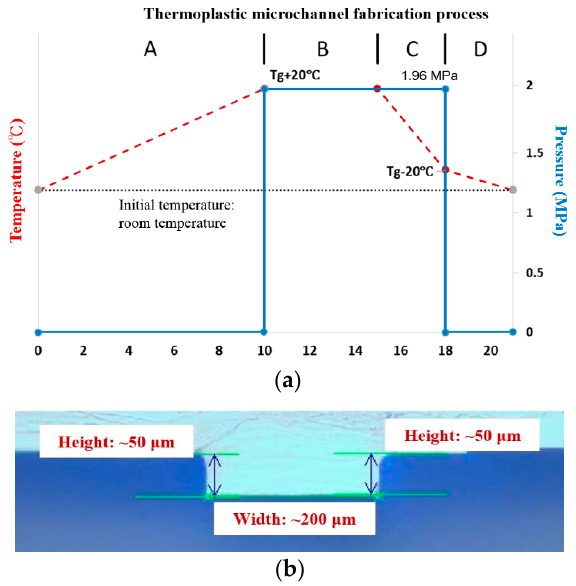
Figure 2. ( a ) Thermoplastic microchannel fabrication process; ( b ) Cross-section of the